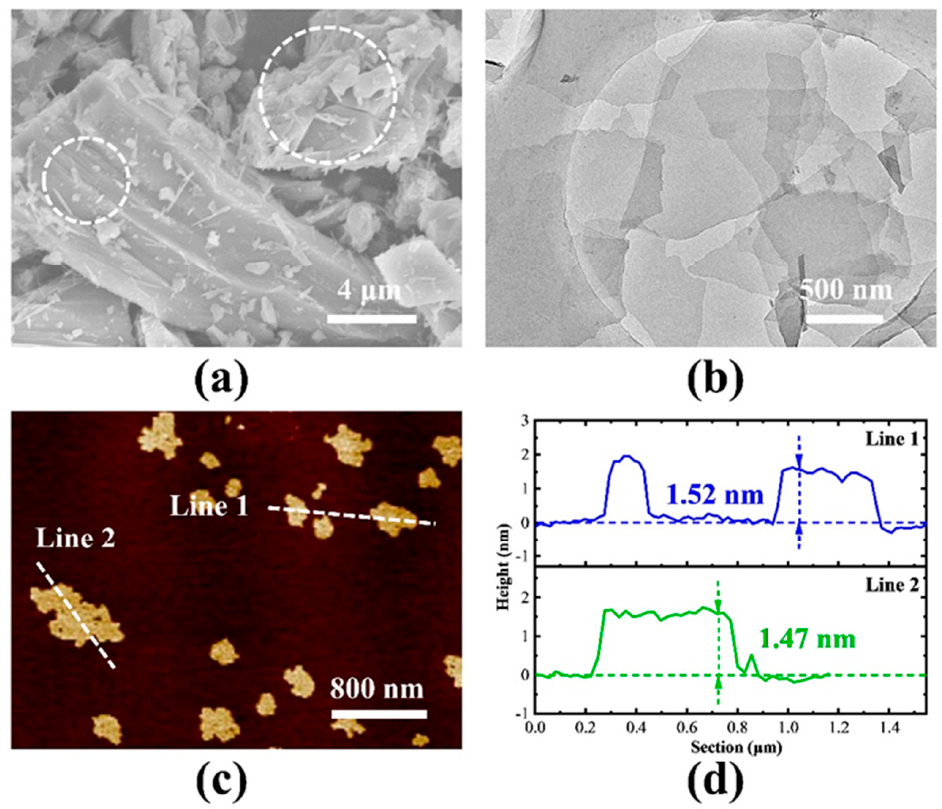
Figure 1. Microscopic morphology of CaSi 2 powders and siloxene nanosheets. SEM image of CaSi 2 ( a ), TEM ( b ), AFM image ( c ), and corresponding heights ( d ) of siloxene